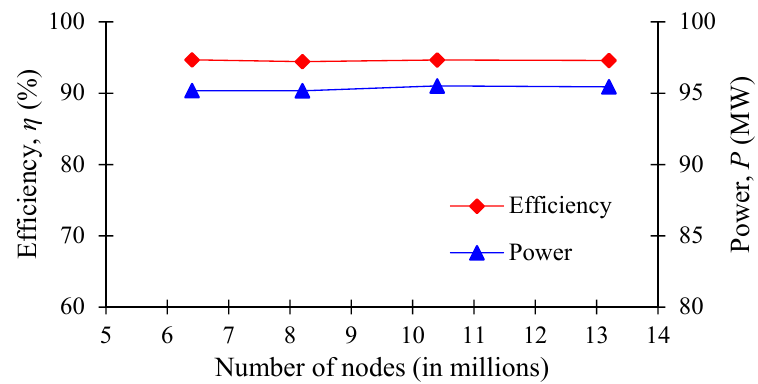
Figure 12. Numerical grids of the 100 MW class Francis turbine.